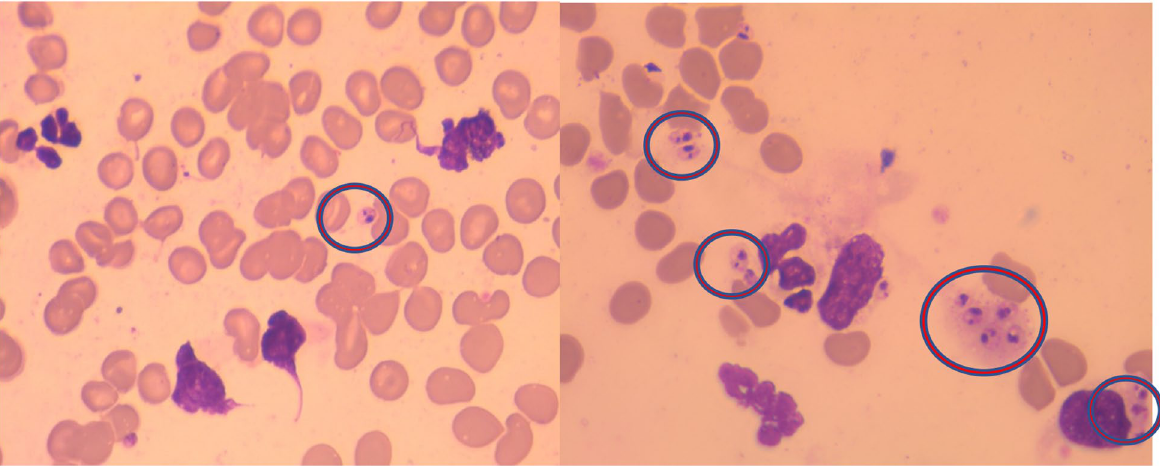
Figure 2. Geimsa stained impression skin smears showing Leishmania species amastigotes (Circled). Reference standard (ITS1 PCR/ nPCR) P valuePositive